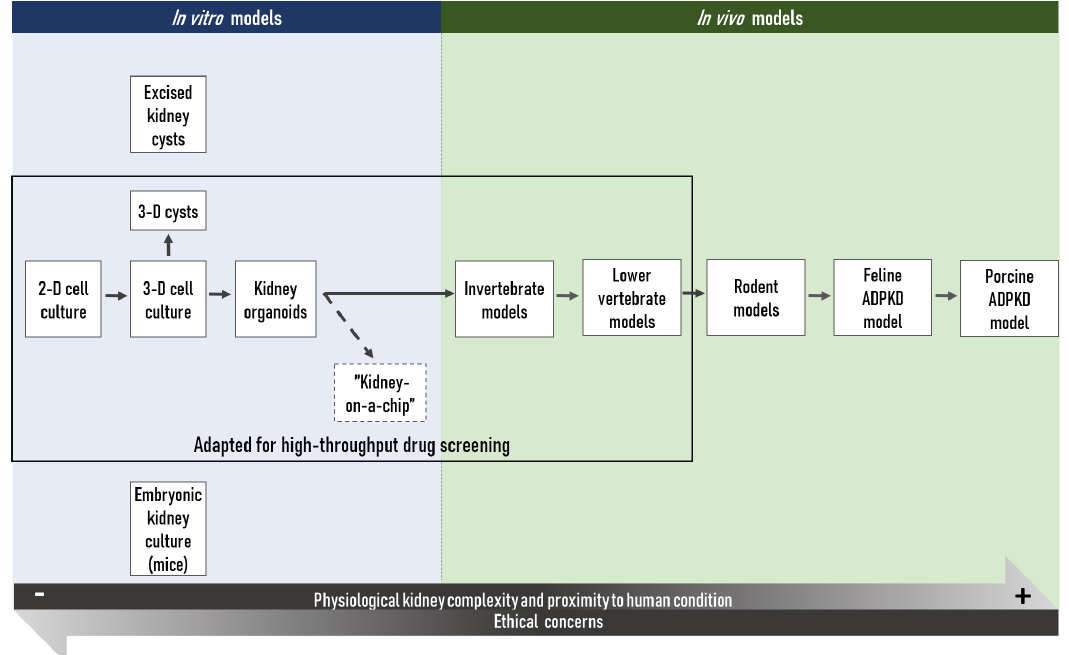
Figure 2. Schematic overview on the different ADPKD research models available to the scientific community. 2D: two-dimensional; 3D: three-dimensional.